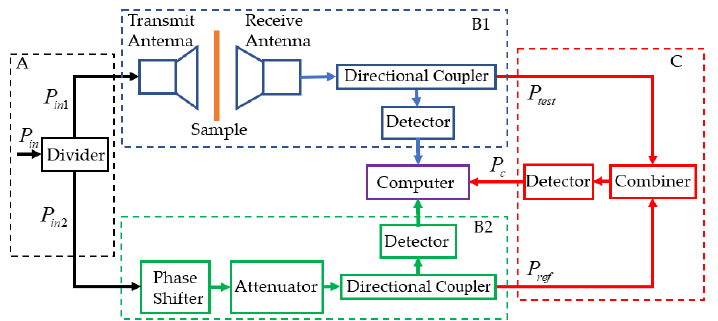
Figure 1. Block diagram of the system designed based on the proposed method.